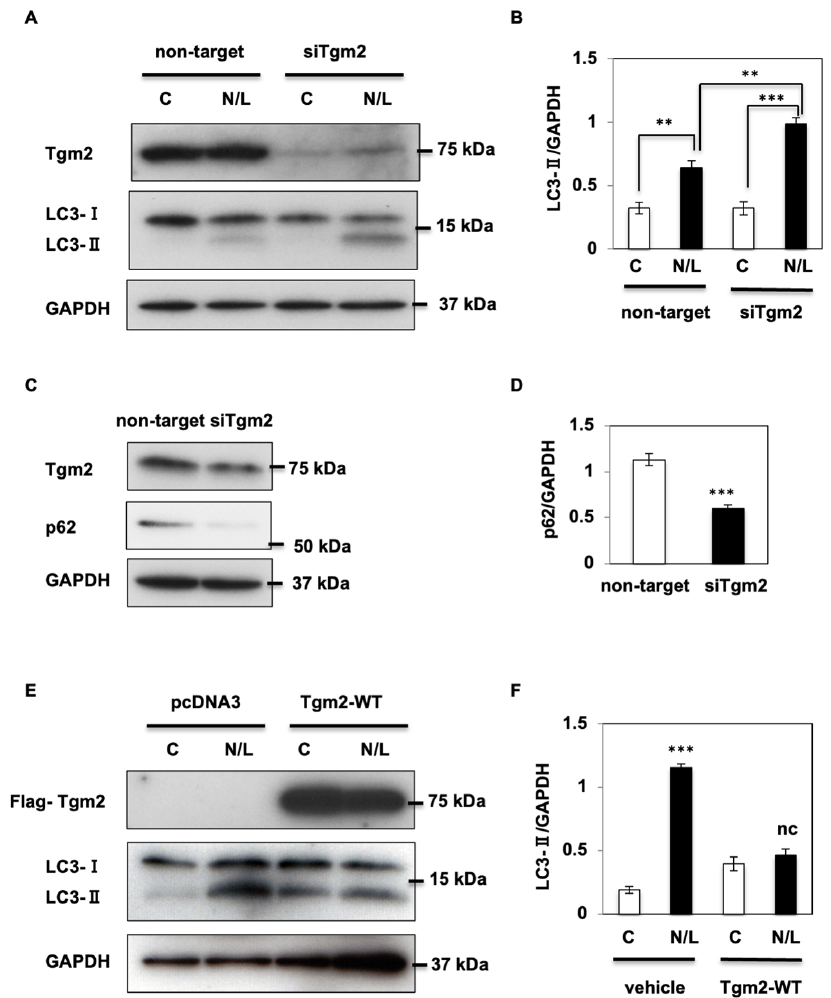
Figure 2. Transglutaminase 2 (Tgm2) regulates autophagy processes in kidney cells. ( A ) Transient knockdown of Tgm2 in HK2 cells was achieved using siRNA technology (siTgm2) and control cells were transfected with non-target RNA. Cells were treated with (N/L) or without (C) NH 4 Cl and Leupeptin for 2 h. Cell lysates were prepared, and Tgm2, LC3-I, and LC3-II protein expression levels were examined using immunoblotting. ( B ) LC3-II signal was corrected using GAPDH levels. ( C ) p62 protein levels were determined using immunoblotting in HK2 cells transfected with siRNA Tgm2 or non-target RNA. ( D ) p62 expression signal was quantified. ( E ) HK2 cells were transfected with a Flag-tagged empty vector (pcDNA) or with a vector expressing Flag-Tgm2 (Tgm2-WT). Tgm2 protein levels were measured using a Flag antibody. LC3-I and LC3-II proteins levels were assessed after a 2 h treatment with NH 4 Cl and Leupeptin. ( F ) LC3-II signal was corrected using GAPDH levels. Data are shown as the mean ± s.e.m., ** p < 0.01, *** p <